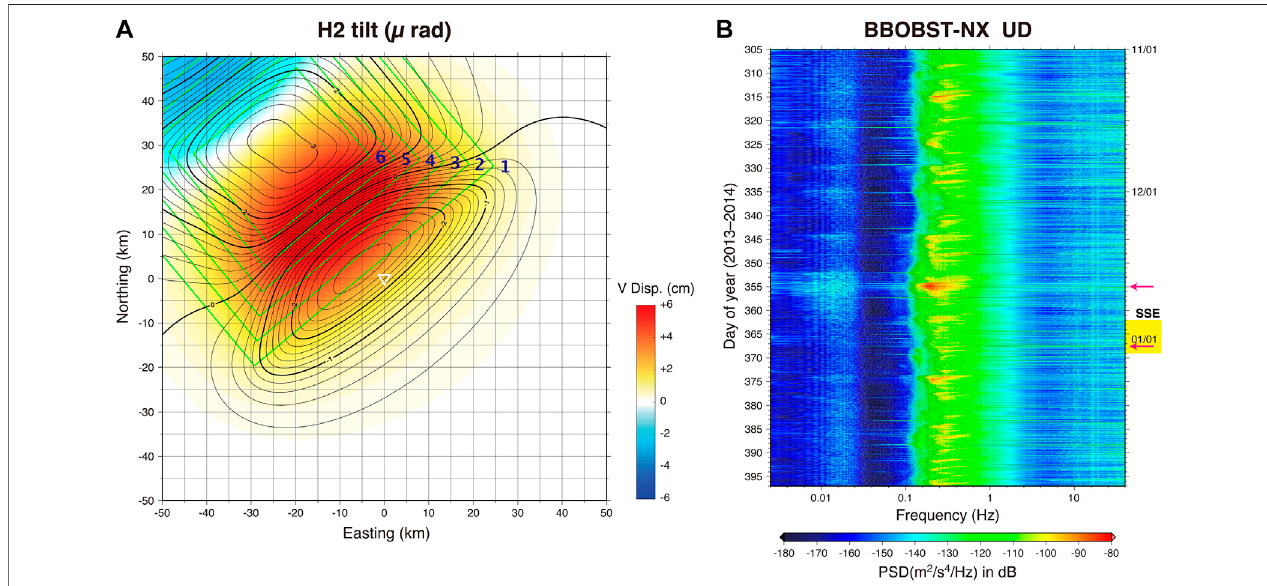
FIGURE10| TheSSEin2013 – 2014offBosoPeninsula. (A) CalculatedresultofH2tilt(contourlinesinµradian)basedonthefaultparametersbySatoetal.(2017). Thered-bluecolorscaleshowstheverticaldisplacementbythetool,Coulomb3.3(Todaetal.,2011).Theoutlinesizeofthefaultplanerectangleis60 km × 60 km,andit isdividedas6graduallyshrinkingrectangles(green,1 – 6)withdifferentslipvalues,2.0,2.5,3.0,4.5,5.5,and6.5 cm,respectively.Theinvertedtriangle(white)showsthe BBOBST-NX position, which is at the H2 tilt of − 2.4 µ radian. (B) The running spectrum of the vertical (UD) component of the broadband sensor ’ s ground velocity signal,before and after theSSE (December28, 2013 – January 4,2014; indicated asayellow rectangle).The time (vertical axis)resolutionis1 h.There wasno signi fi cant changeinsignallevelinthe < 0.1 HzfrequencyrangeduringtheSSE.SomeearthquakesaroundtheSSEsourceareaoccurred,asshown inthe > 2 Hzfrequencyrange. Two purple arrows indicate the two earthquakes mentioned in SSE Estimations .